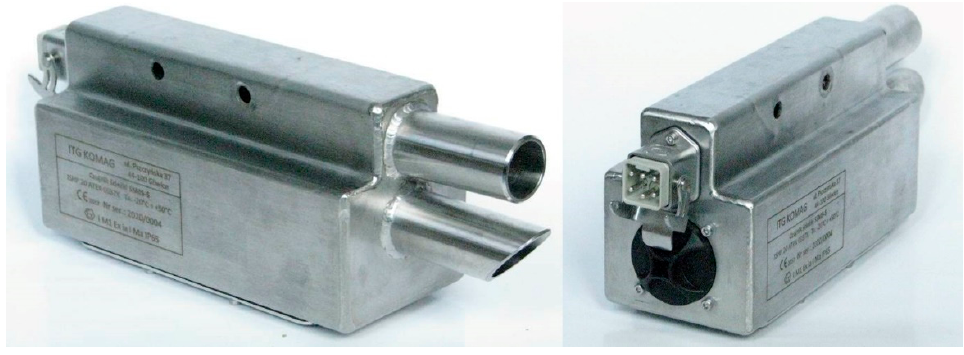
Figure 2. Tip to face distance sensor SSMS-S [16,17].